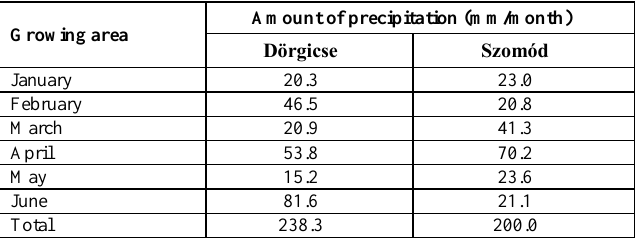
Table 1/c. Quantity of precipitation (mm) prior to harvest period in 2017 (mm/month) (data were provided by OMSZ-National Meteorology Service).